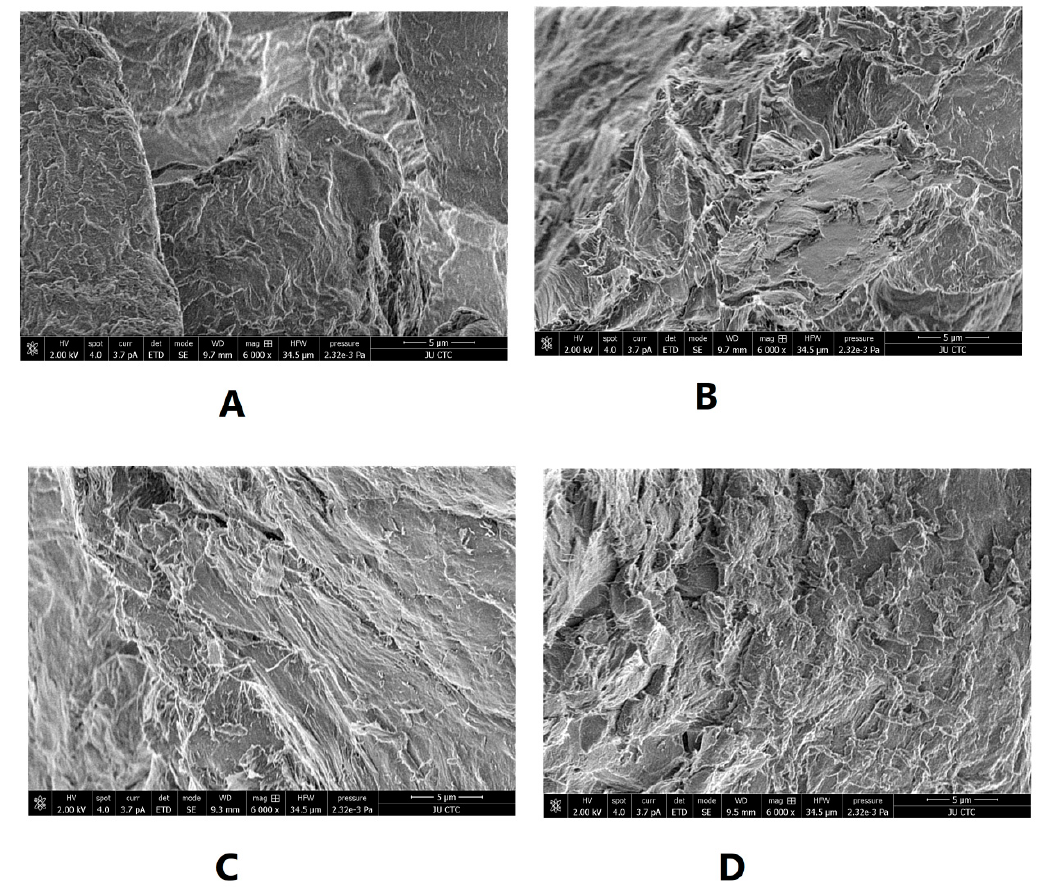
Figure 6. SEM of non-compacted Avicel PH-101 101 ( A ), roller compacted Avicel-1st compaction cycle ( B ), roller compacted Avicel-2nd compaction cycle ( C ), and roller compacted Avicel-3rd compaction cycle ( D ) at magnification of 6000×.